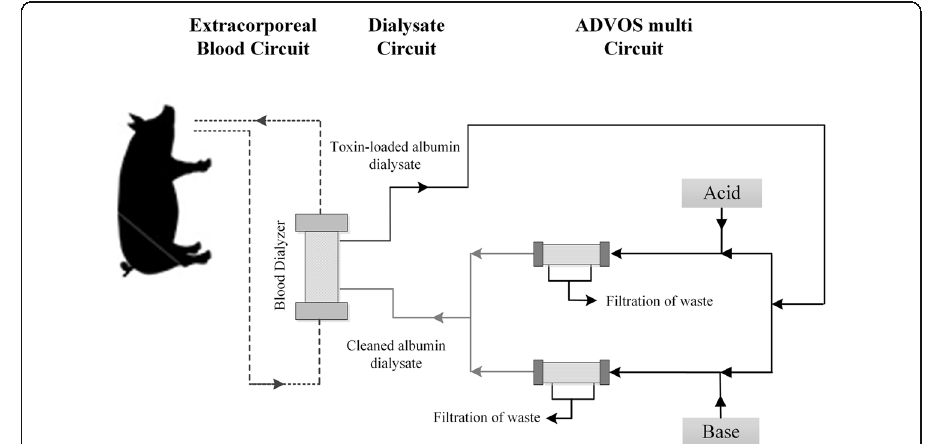
Fig. 2 A schematic representation of the laboratory prototype to conduct the ADVOS procedure. Albumin dialysis is performed through a three-circuit system (i.e. blood, dialysate, and ADVOS multi) that allows